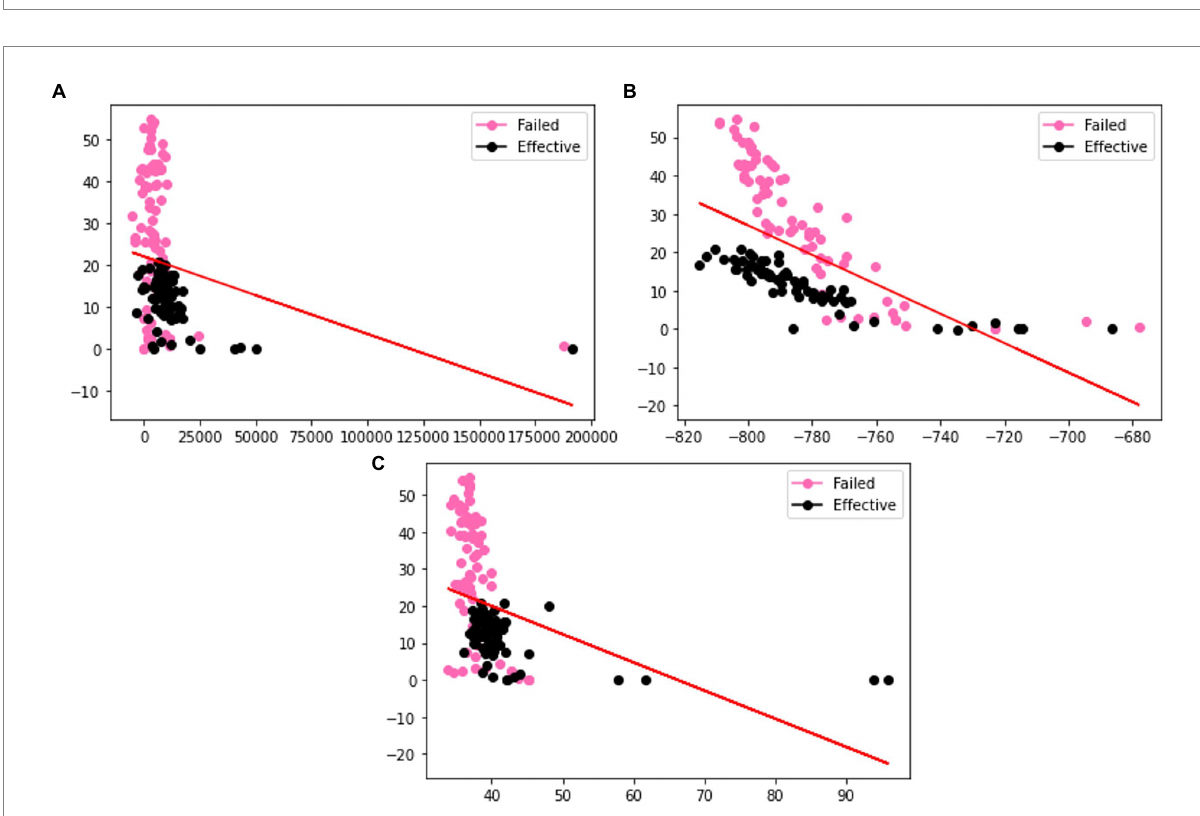
FIGURE 4 Visualization of the distributions of different columns (A) Rct (B) OCP (C) Rsoln of VAE generated dataset. Color coded by the label where pink is a failed coating (normalized corrosion rates greater than 1.000), and black is an effective coating (normalized corrosion rates under